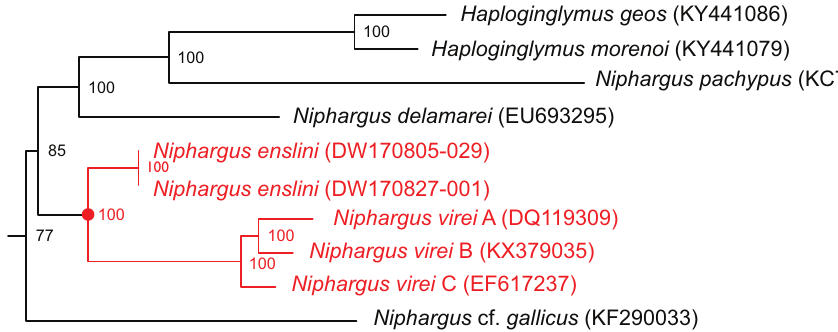
Figure 3. A subset of the phylogenetic tree with Niphargus enslini and its closest neighbours of the Niphargus virei sister group, reconstructed using maximum likelihood (IQTree2), based on a fragment of the 28S rRNA gene. Ultrafast bootstrap supports are shown on nodes. The N. virei clade, which includes N. enslini (100% support), is reported in red. A full tree is shown in the Suppl. material 1: Fig.